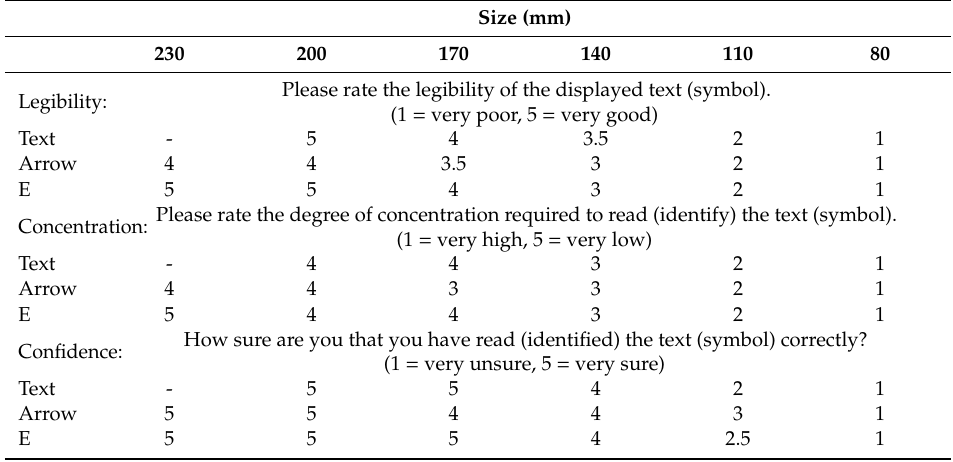
Table 5. Subjective participant ratings on a 5-point Likert scale with regard to legibility, concentration, and confidence ( n = 30).